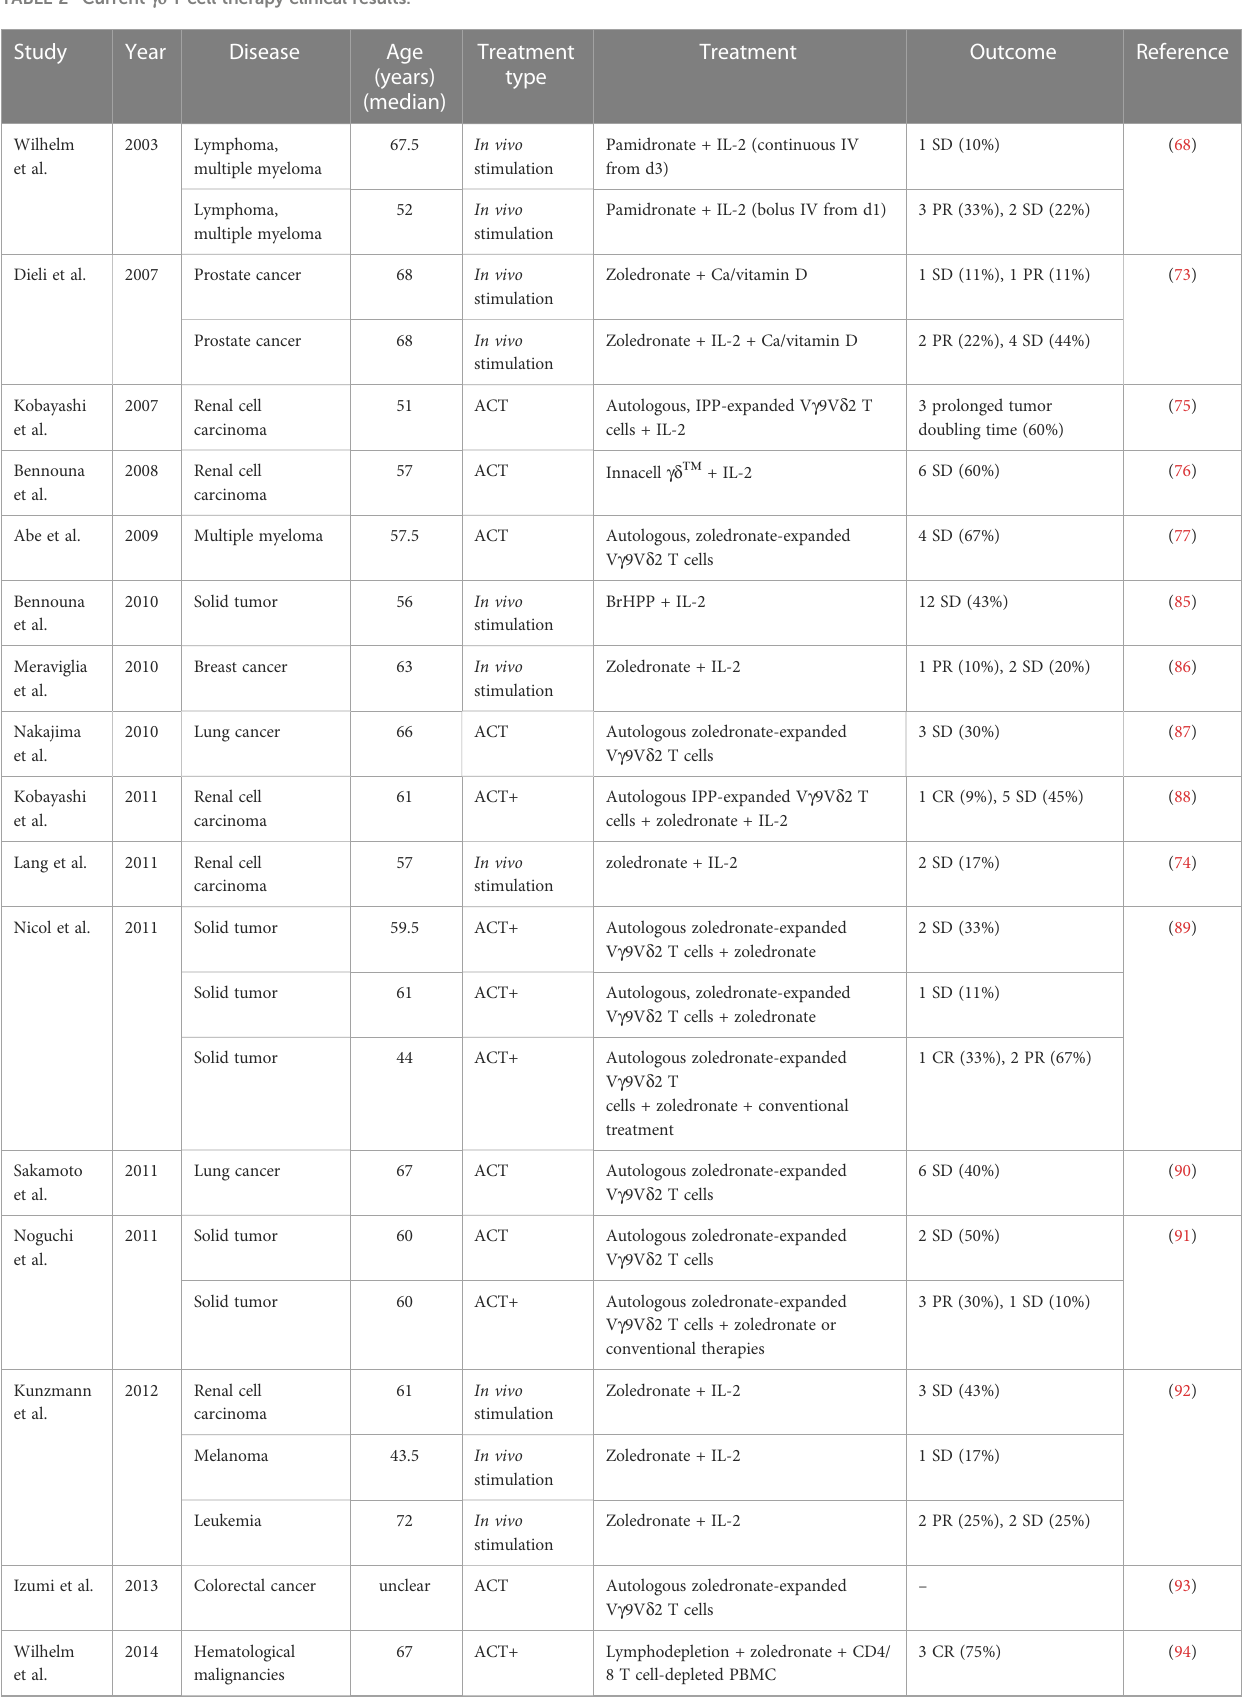
TABLE 2 Current gd T cell therapy clinical